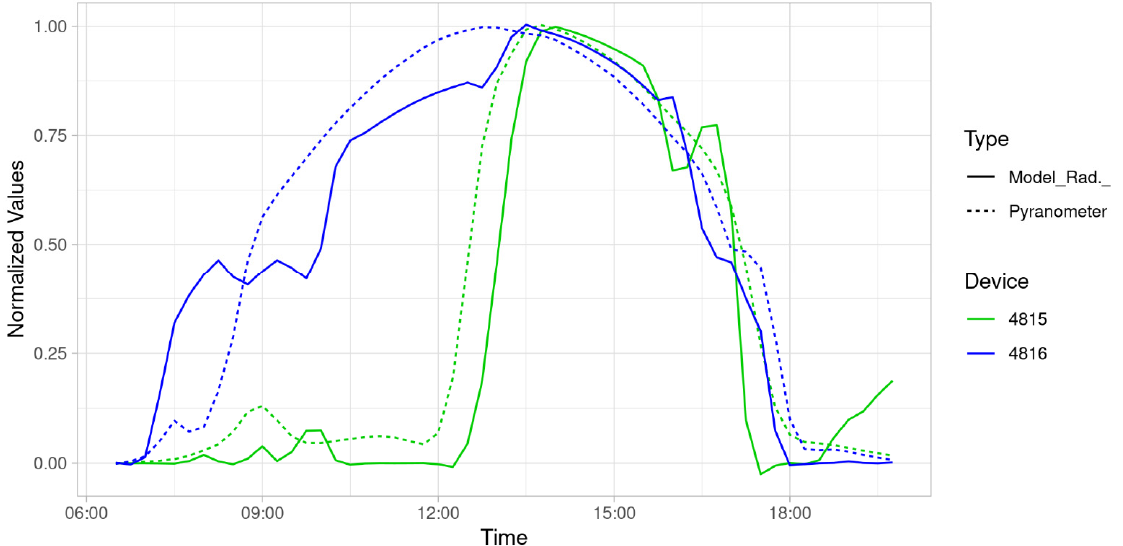
Figure 10. Time distribution (27 July 2022) of the fraction of direct-beam/diffuse-only radiation (i.e., light vs. shadow) and corresponding solar radiation values from the pyranometers. All data are normalized between 0 and 1.